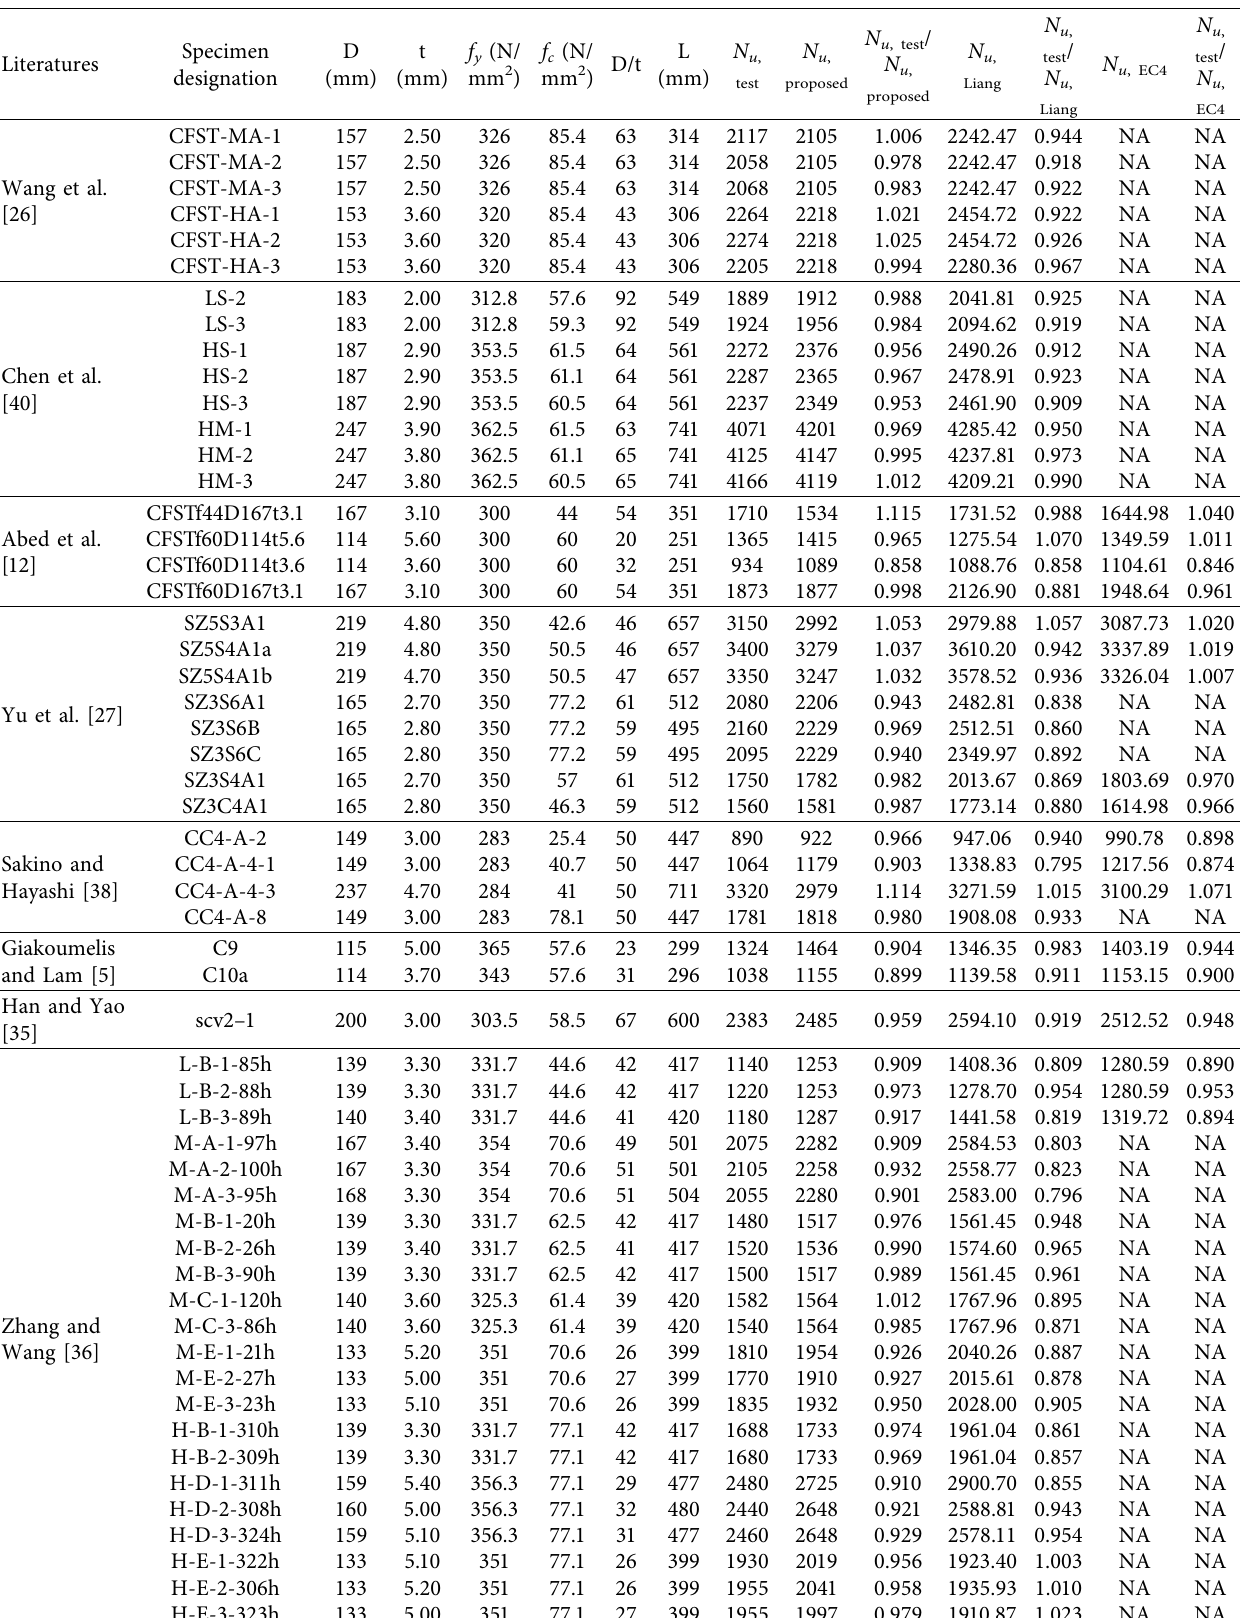
Table 5: Verification of proposed model results with test results available from the